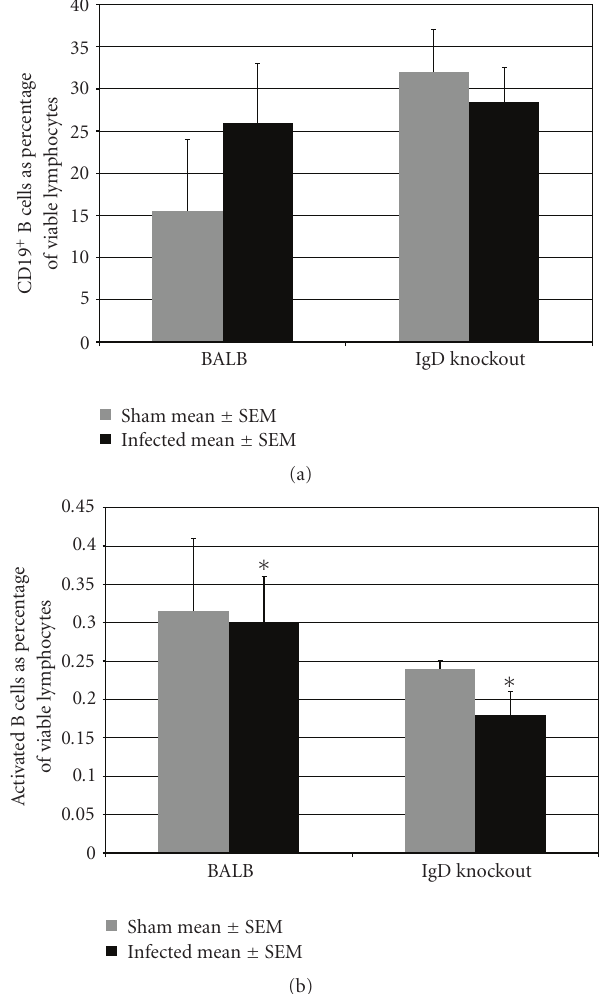
Figure 3: P gingivalis- infected IgD deficient mice had a lower proportion of activated B cells than infected immune normal BALB/cJ mice . (a) The total B cell population: the percentage of total viable CD19 + B cells in the sham-infected mice were the same in both strains ( P > . 05). In neither mouse strain was the total B cell population changed by P. gingivalis infection ( P > . 05, infected compared to sham-infected mice). (b) Activated B cell population: the proportion of activated B cells in infected IgD deficient mice were significantly lower than in infected BALB/cJ mice, ( P < . 05, indicated by ∗ ) n = 8; 42 days